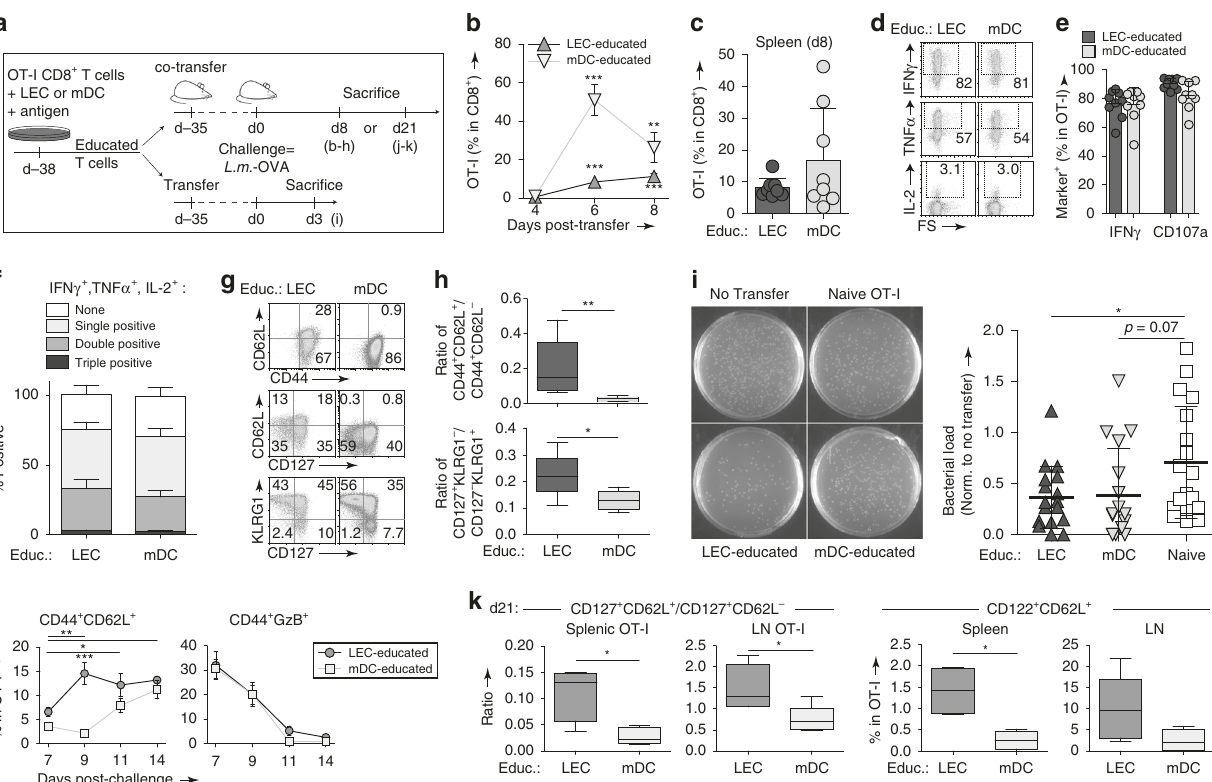
Fig. 8 LEC-educated CD8 + T cells protect against infection and give rise to a persistent secondary memory population. a Experimental setup: LEC- educated (CD45.1/2 + ) and mDC-educated CD45.1 + OT-I cells were co-transferred (1:1, 10 5 total cells/mouse) into healthy wild-type mice a – h , j , k , and challenged 5 weeks later with L.m.- OVA (10 3 cfu/mouse i.v.) and sacri fi ced 8 days a – h or 3 weeks later j , k . b , c Frequency of OT-I cells among all CD8 + T cells in the b blood and c spleen. d – h Splenic OT-I cells were further characterized for: d Intracellular staining for IFN γ , TNF α , and IL-2 after ex vivo re- stimulation; e frequency of IFN γ + and CD107a + cells; f frequency of multifunctional (IFN γ , TNF α , and IL-2) cells; g expression of CD44, CD62L, CD127, and KLRG1; and h (top) ratio of T CM (CD44 + CD62L + ) to T eff/EM (CD44 + CD62L − ) cells and (bottom) ratio of memory precursor effector cells (CD44 + CD127 + KLRG1 − ) to short-lived effector cells (CD44 + CD127 − KLRG1 + ). i Colony-forming assay performed 3 days following challenge with L.m.- OVA (10 4 cfu/ mouse), which occurred 5 – 9 weeks after adoptive transfer of LEC-educated or mDC-educated OT-I cells, or resting OT-I cells (educ: naïve) as a control. (left) Representative photographs of spleen suspensions from mice receiving indicated OT-I cell populations, cultured on BHI agar plates overnight. (Right) Quanti fi cation of bacterial burden, normalized to the c.f.u. detected in the negative control (no transfer) group ( n = 5 – 6 per experimental session: 1.5× 10 8 c.f.u., 5.6× 10 4 c.f.u., and 3.9× 10 5 c.f.u. for the three experiments). j Kinetics in the frequency of CD44 + CD62L + and CD44 + GzB + phenotype on circulating OT-I at the indicated timepoints post-challenge. k Ratio of T CM (CD44 + CD127 + CD62L + ) to T EM (CD44 + CD127 + CD62L − ) cells, and percentage of CD122